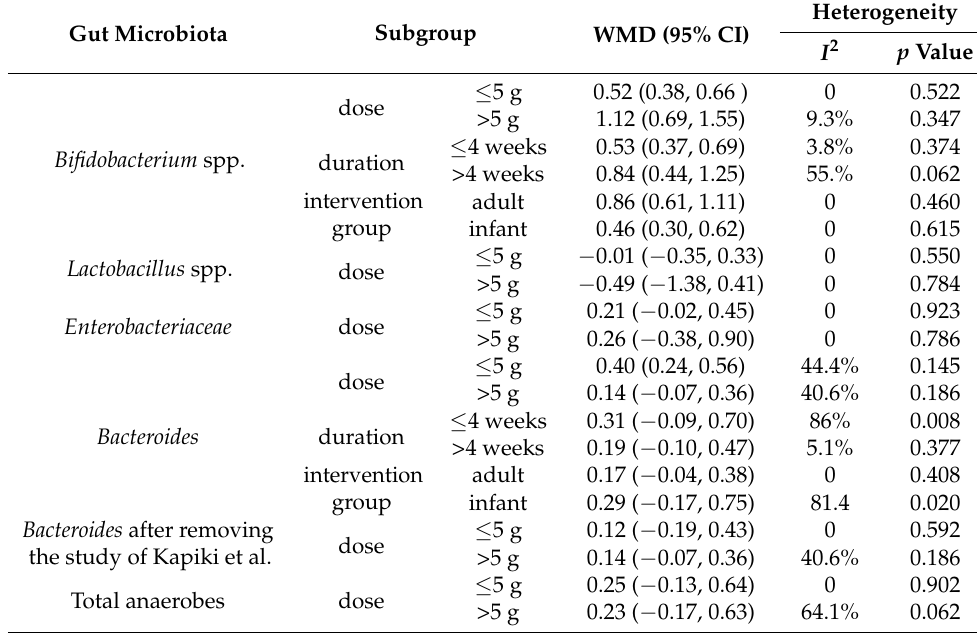
Table 2. Subgroup analysis of changes in intestinal flora before and after